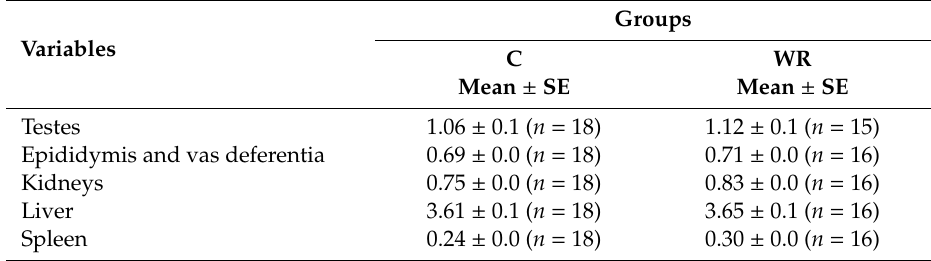
Table 3. Relative weights (%) of reproductive and body organs of F1 male rat o ff spring in control and water-restricted group.